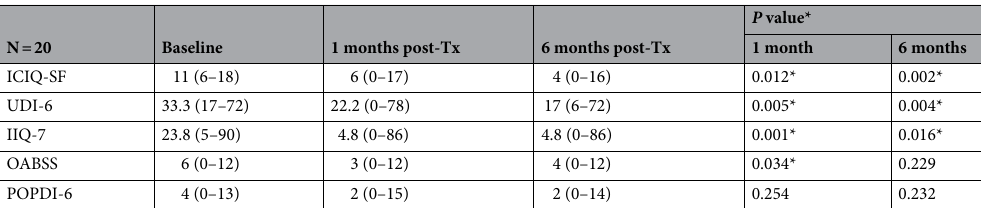
Table 2. Questionnaire results at baseline and 1, 6 months post-treatment. Tx treatment, ICIQ-SF International Consultation on Incontinence Questionnaire-Short Form, UDI-6 Urogenital Distress Inventory, IIQ-7 Incontinence Impact Questionnaire, OABSS Overactive Bladder Symptom Scores, POPDI-6 Pelvic Organ Prolapse Distress Inventory 6. Values are expressed as median (range). *Statistical significance; Wilcoxon signed rank